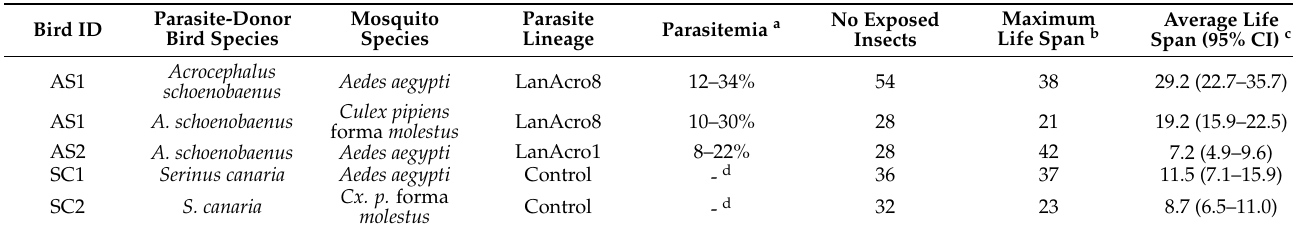
Table 1. Control (non-infected) and experimentally exposed to Lankesterella kabeeni infection mosquitoes and their life span after blood